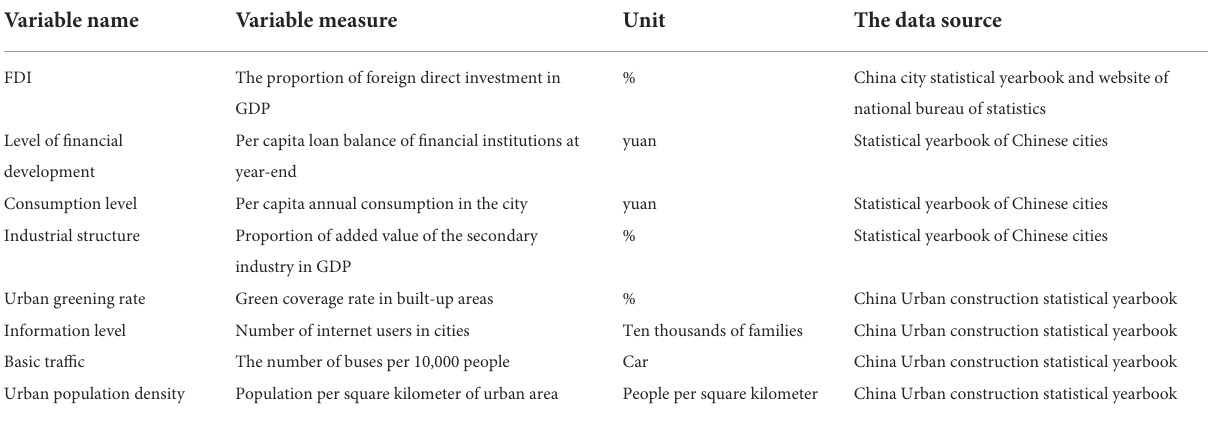
TABLE 2 Control variables and data